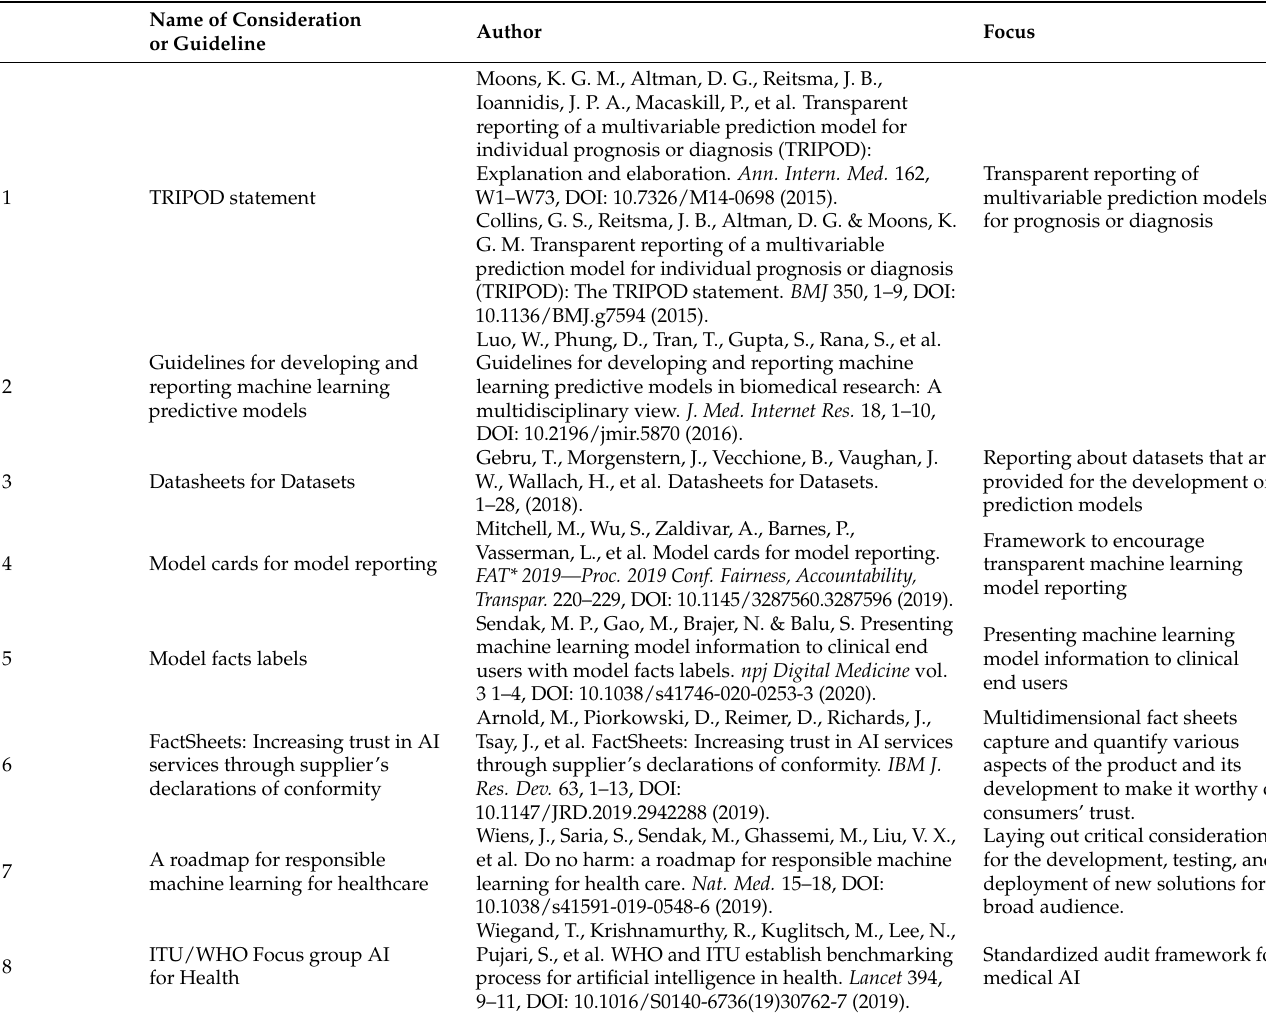
Table A1. Considerations and guidelines for transparent reporting of clinical prediction models, development of Artificial intelligence (AI), and trustworthy AI. Note that this list is not